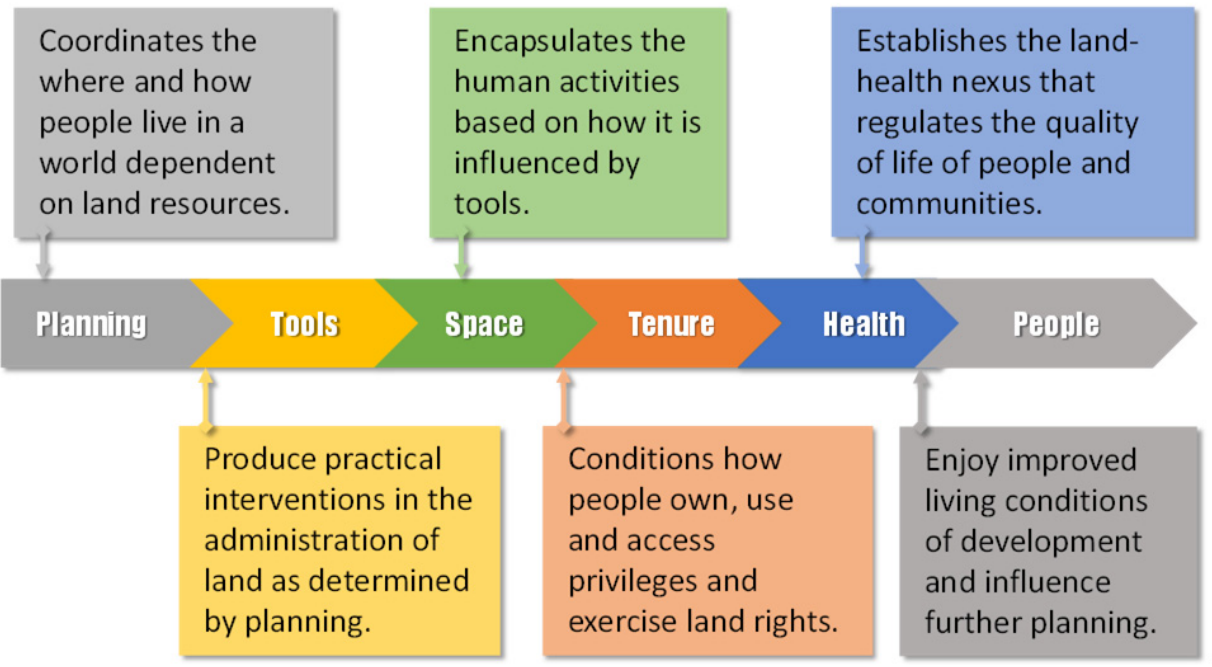
Figure 1. The relationship between people, tenure, planning, tools, space, and health (from land perspective) (authors’ illustration).